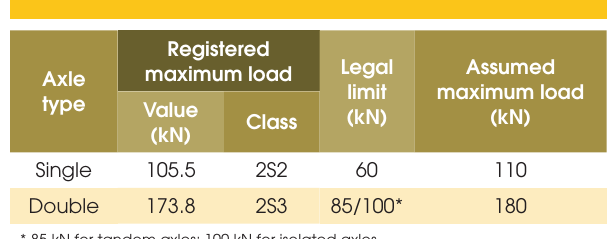
Table 4 – Population models fitted to some wheelbases; d